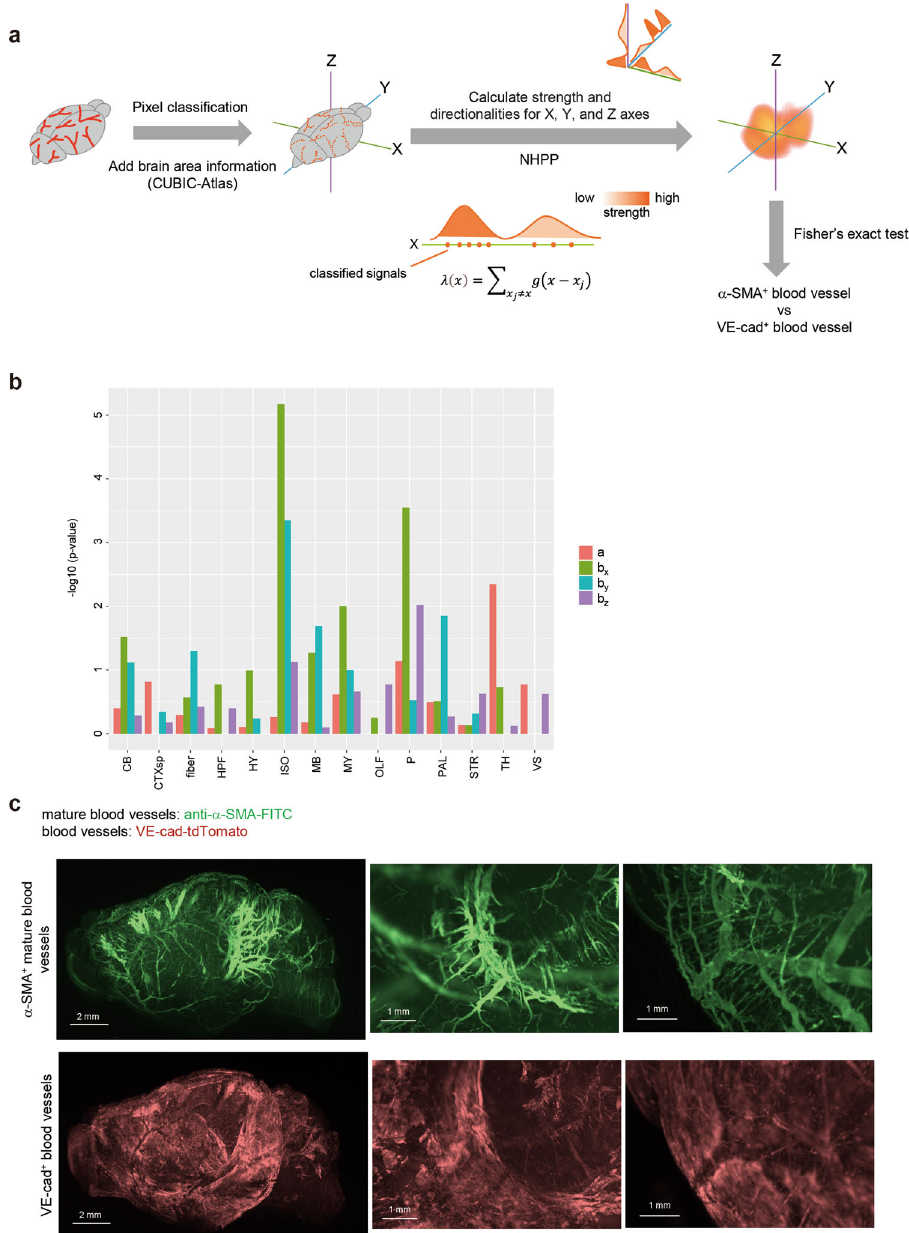
Fig. 4 | Analysis of brain blood vessels using NHPP. a Overview of analysis pro- cedure using CUBIC-Atlas and NHPP. First, signals of blood vessels were classi fi ed usingilastiksoftware,thenthebrainanatomicalinformationisaddedtothemusing ANTs and CUBIC-Atlas. To evaluate the intensities of blood vessels, non- homogeneous Poisson process (NHPP) was applied. In this method, strength (a) and directionalities ( b x , b y , b z ) can be calculated using the pixel-based classi fi ed signals as the points. To compare the difference between α -SMA + mature blood vesselsandVE-cad + bloodcapillaries,Fisher ’ sexacttest(two-sided)wasused. b The result of Fisher ’ s exact test between α -SMA + mature blood vessels and VE-cad + blood capillaries in mouse brain. Strength (a) and directionalities ( b x , b y , b z ) were calculated using NHPP and the results of NHPP in each brain area were used in the